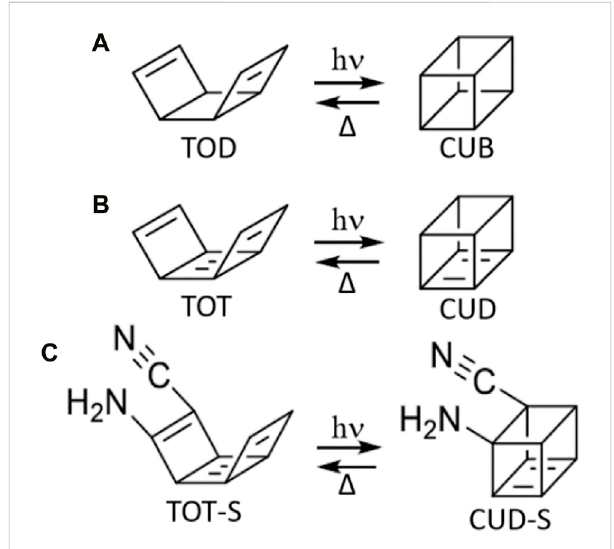
FIGURE 2 (A) TOD/CUB system,leadingtothephotochemical formation of cubane; (B) TOT/CUD system, leading to the photochemical formation of cubadiene, and (C) its substituted derivative TOT-S/ CUD-S. To serve as molecular solar thermal systems, the photoproduct needs to be a photochemically stable high-energy isomer and should be capable of thermal reversion to its initial low- energy